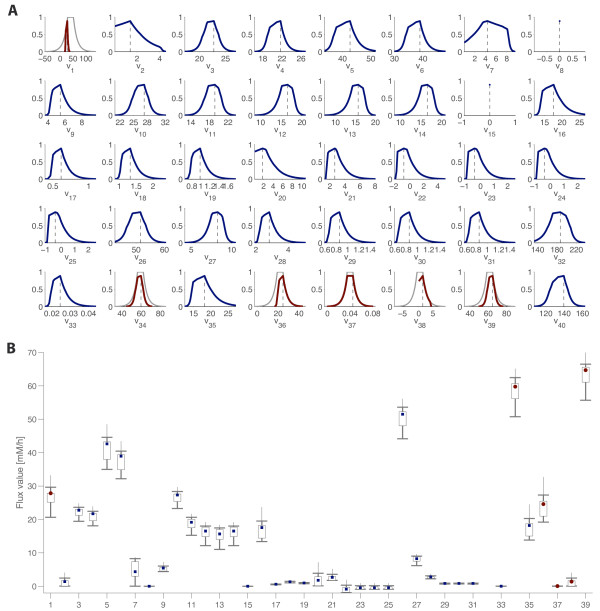
Possibilistic flux estimation for C. glutamicum. The measured fluxes are vGLC (1), vO2 (34), vNH3 (35), vLY (37), vThre (38) and vCO2 (39) and vBio (36). (A) Marginal possibility distributions for each flux are depicted. The original distribution of single measurements appear in grey (thick line). (B) The maximum possibility flux estimation (circles and squares for measured and non-measured fluxes, respectively) and the flux intervals for conditional possibilities of 0.8 (box), 0.5 (thick line) and 0.1 (narrow line) are depicted. All fluxes in mM/h.